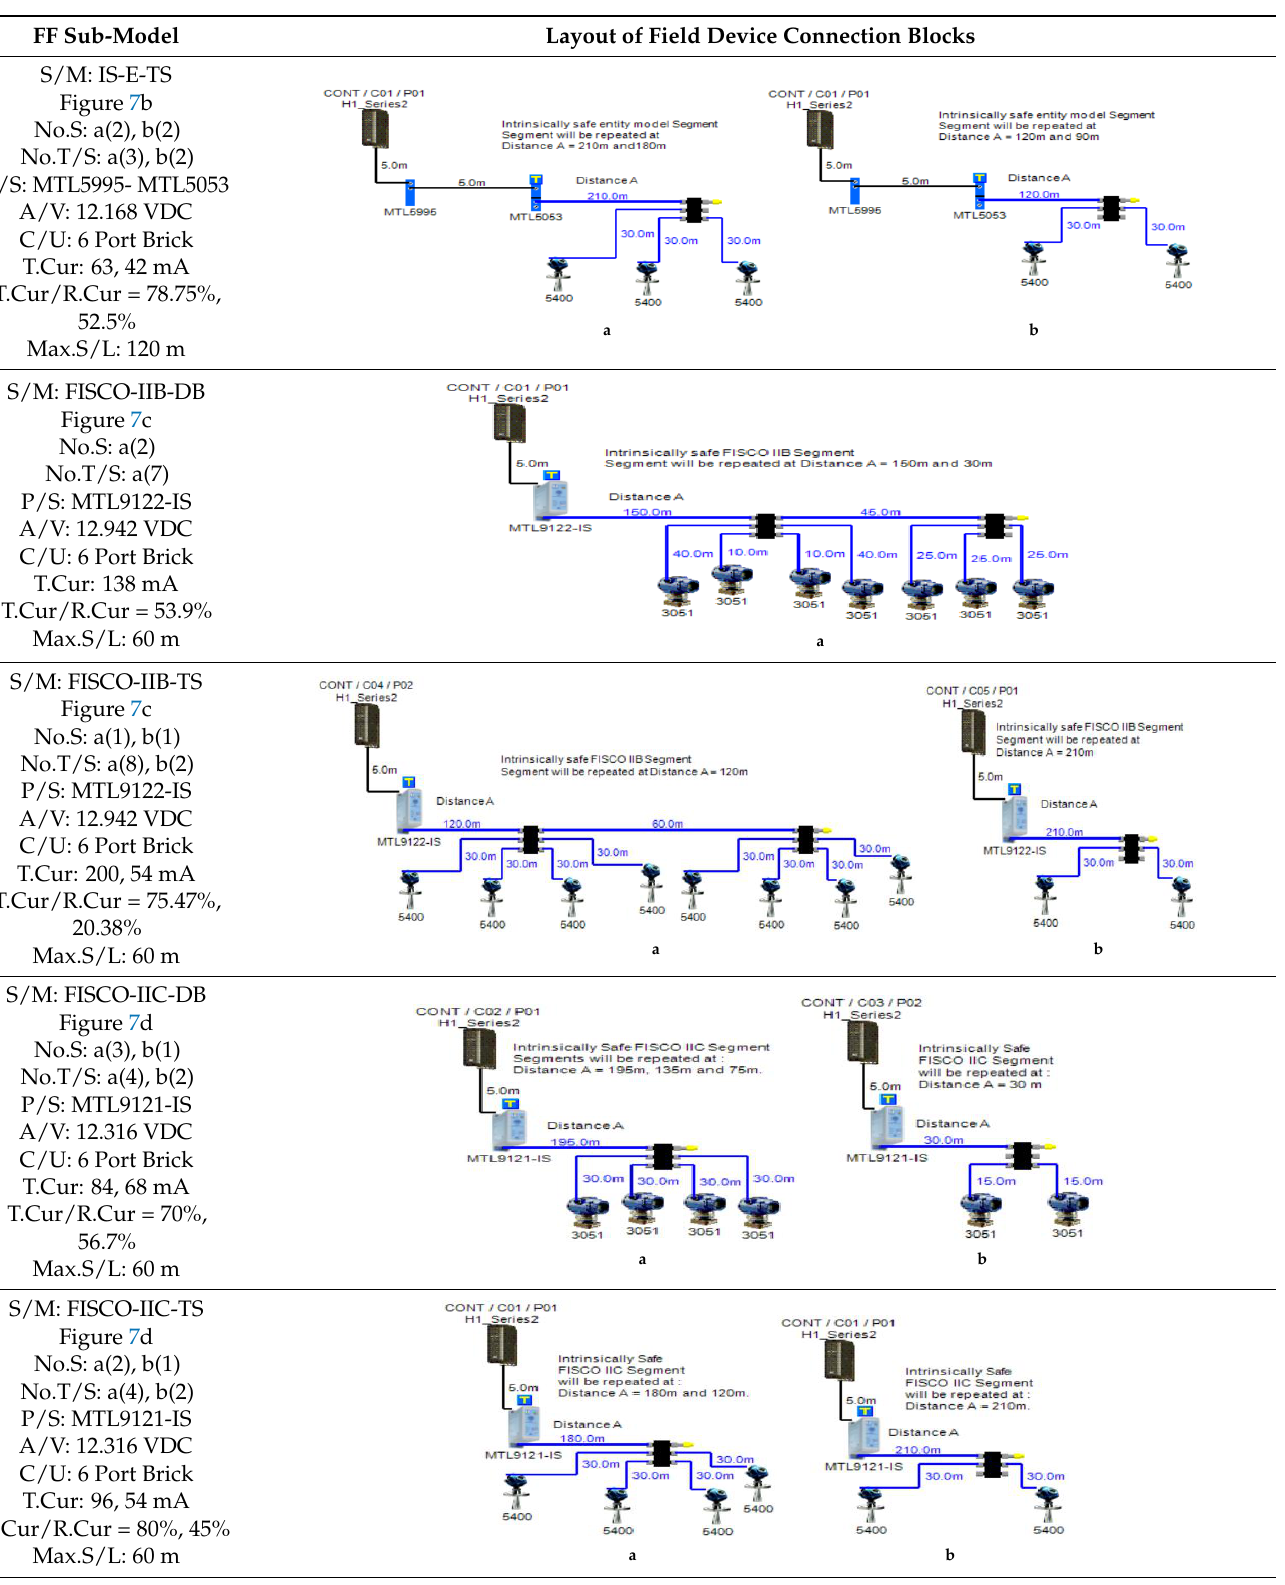
Figure 7b No.S: a(2), b(2)